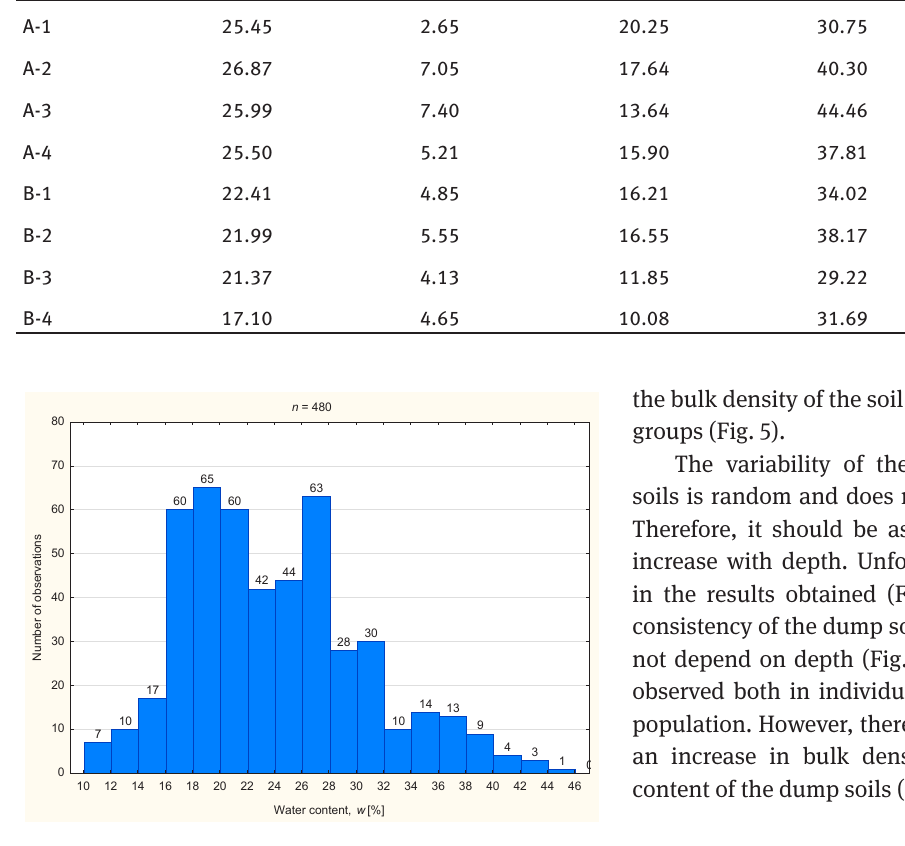
Table 2: Results of water content tests of the dump soil in particular soil groups. Dump soil